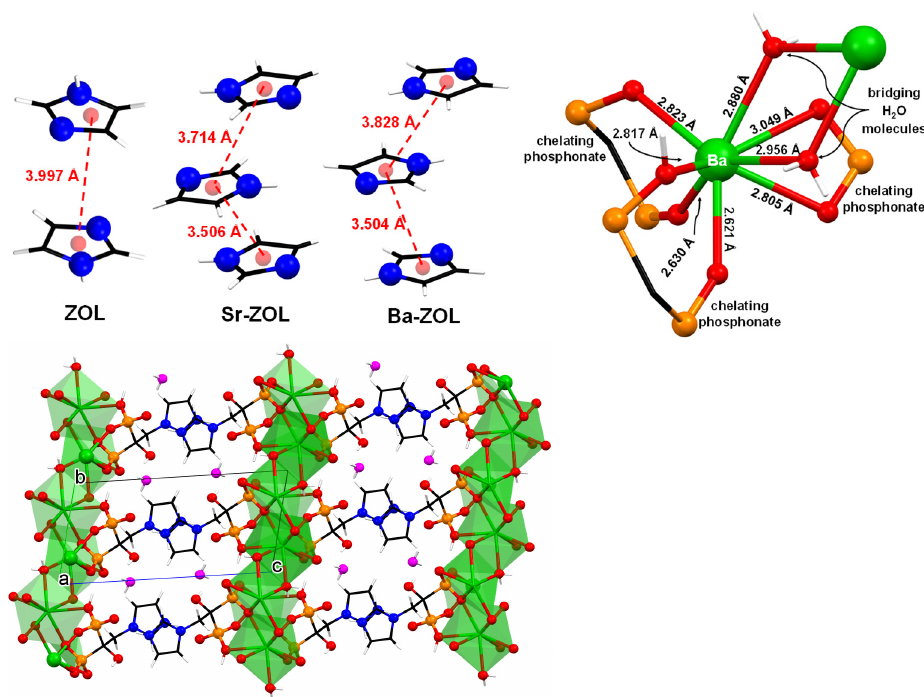
Figure 4. Various views of the crystal structures of Sr/Ba–ZOL: comparative π−π stacking interac- tions ( upper left ). The coordination sphere of the of Ba 2+ center with Ba–O bond distances ( upper right ). Packing of three 2D layers along the b-axis ( lower ). Color codes: Ba, green; P, orange; O, red; C, black; N, blue; H, white, lattice H 2 O, magenta.